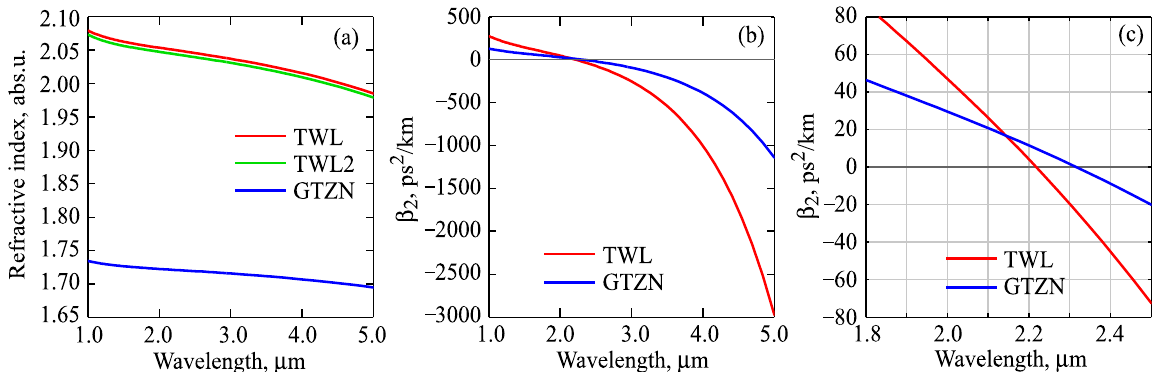
Figure 1. ( a ) Refractive indices of TWL, TWL2, and GTZN glasses calculated from Equation (1) using the Sellmeier constants from Table 1. Calculated dispersion of TWL and GTZN glasses in a wide wavelength range ( b ) and near ZDWs ( c ).